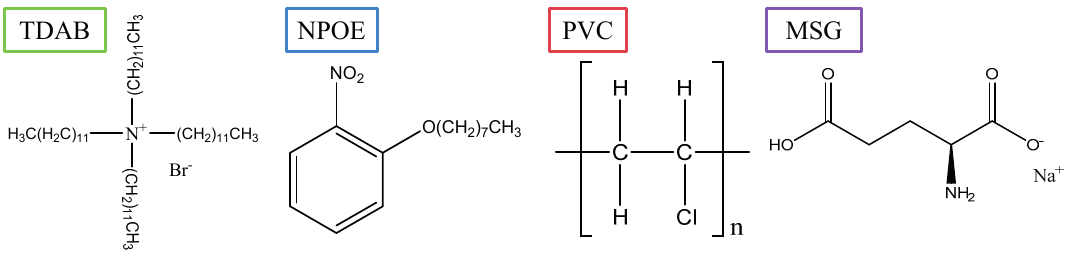
Figure 5. The chemical structures of TDAB, NPOE, PVC and